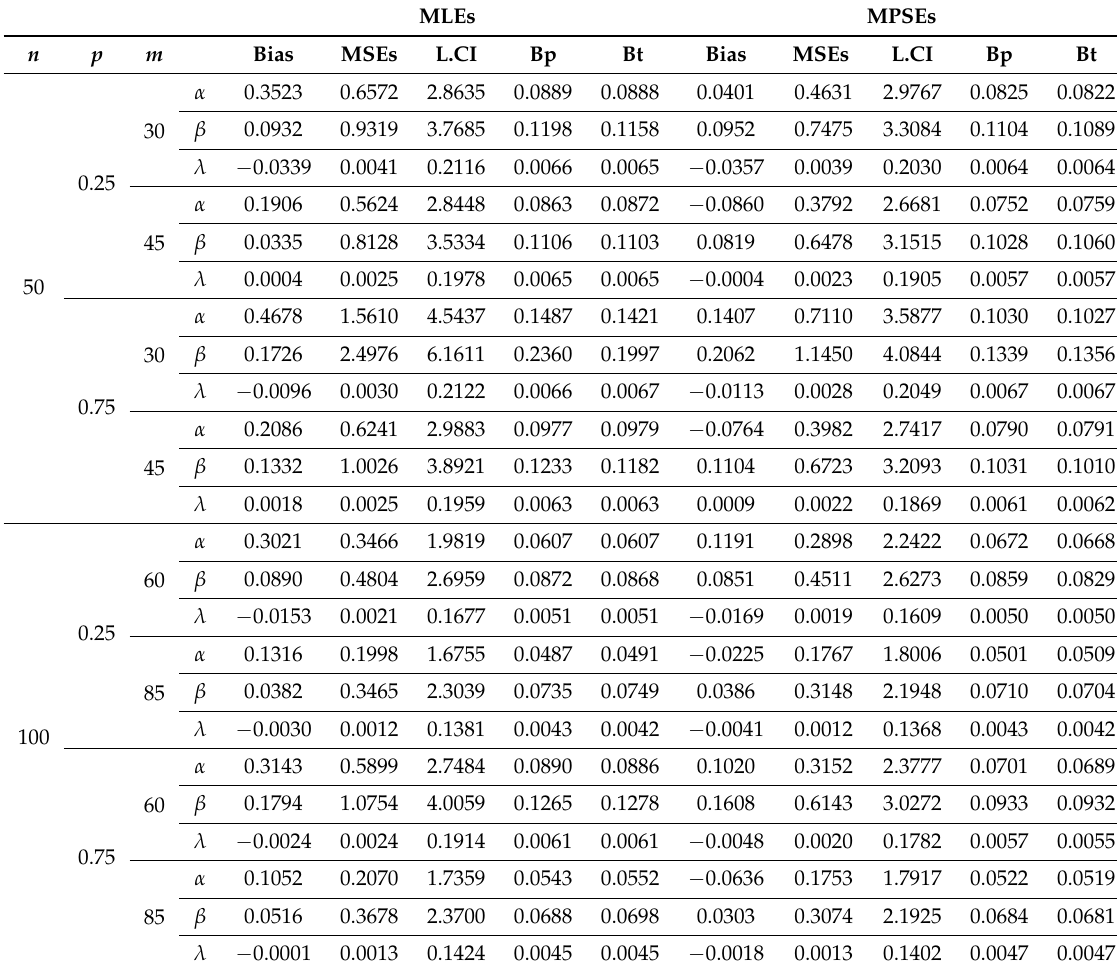
Table 1. The maximum likelihood estimators (MLEs) and maximum product of spacing estimators (MPSEs) of the EOWE parameters under progressive type-II censoring scheme with binomial removals for Case